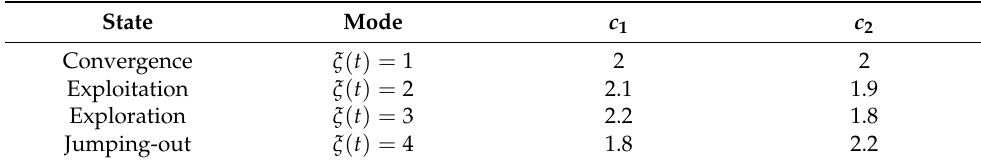
Table 1. Strategies for selecting c 1 and c 2 .